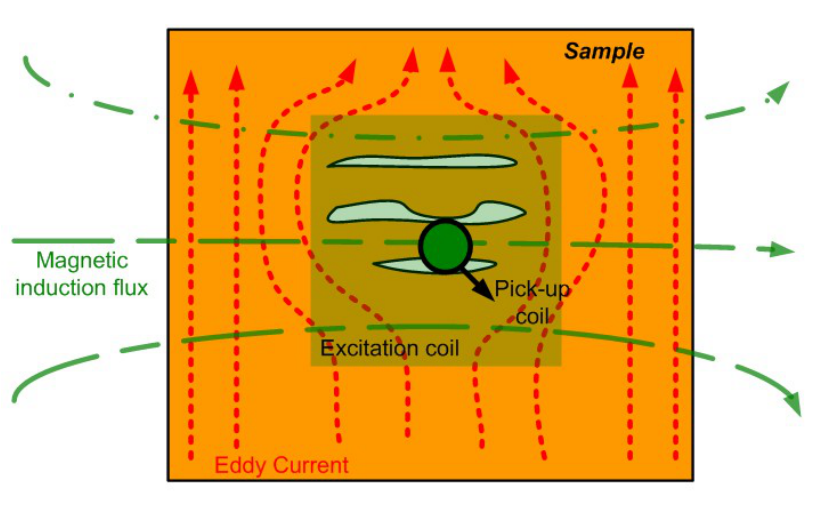
Figure 21. Top view of PET probe in direction of magnetic induction